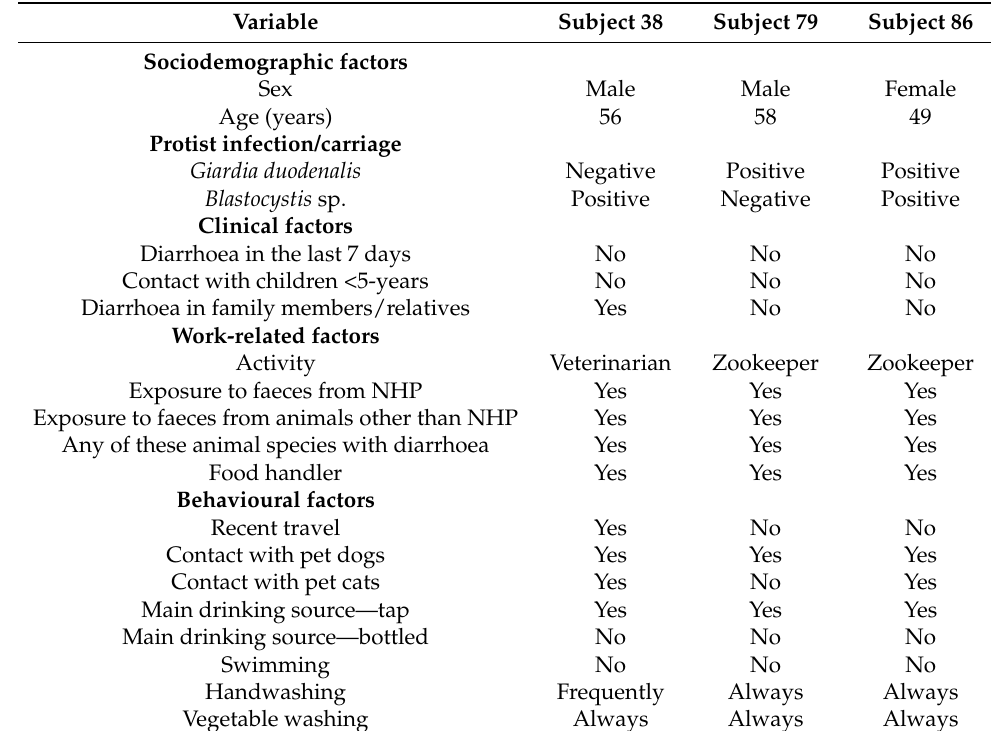
Table 4. Variables potentially associated to G. duodenalis infection and Blastocystis sp. carriage in staff at the C ó rdoba Zoo Conservation Centre